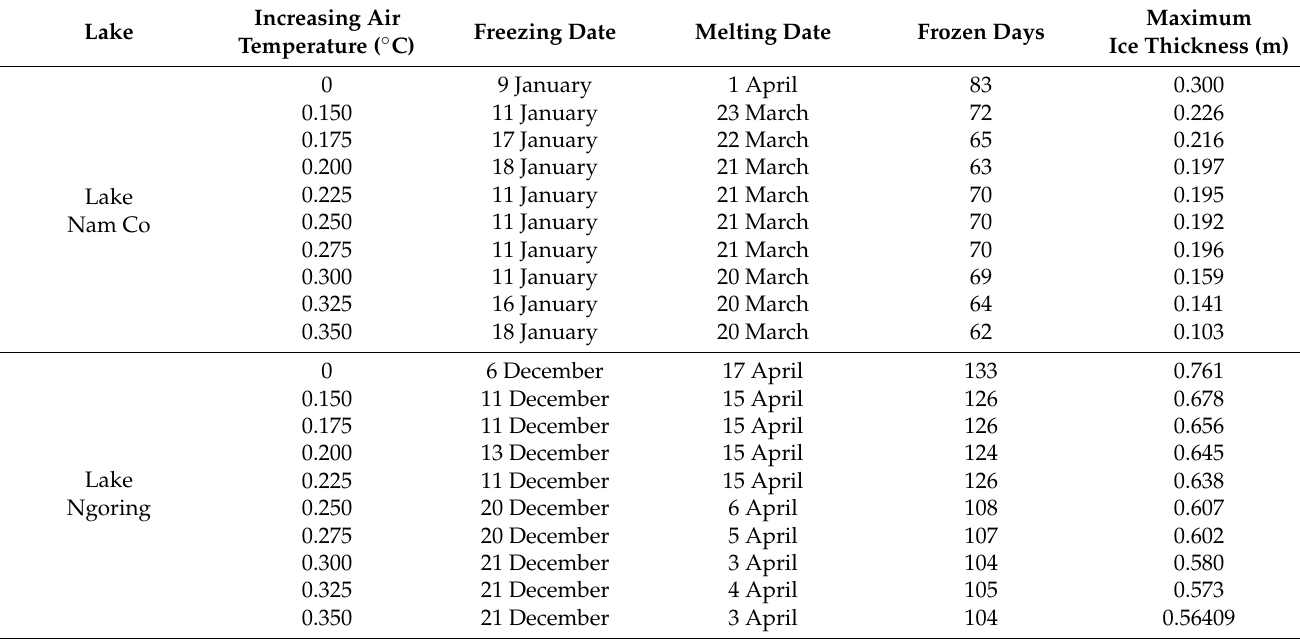
Table 1. Changes in lake ice thickness, the number of frozen days, and dates for the onset of freeze-up and melt when the air temperature increases by between 1.5 ◦ C and 3.5 ◦ C at Lake Nam Co and Lake Ngoring (averaged from January 2012 to December